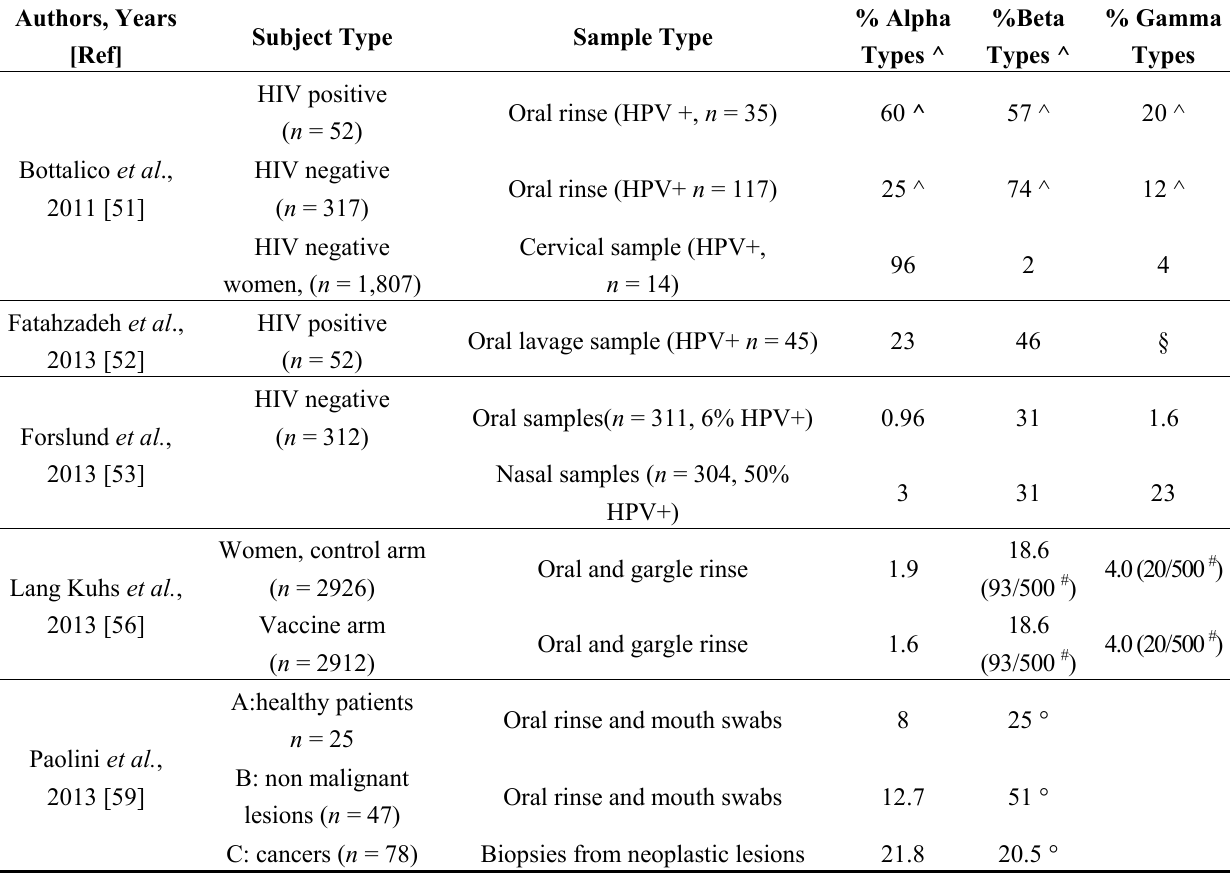
Table 1. Main papers about beta, gamma HPV type prevalence description in oral